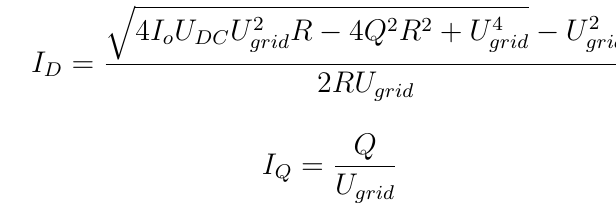
Figure 2. Constant Power Circles on the F